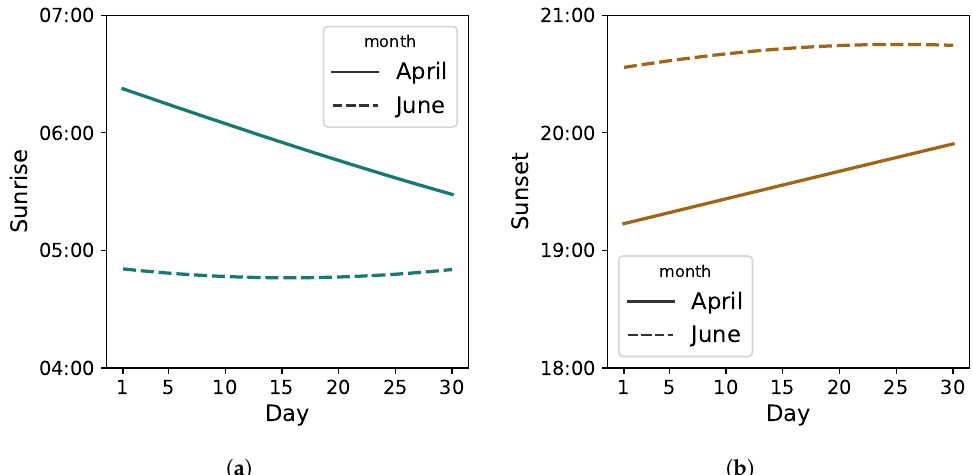
Figure 11. Sunrise ( a ) and sunset ( b ) times of June 2016 and April 2017 projected to the same figure to highlight the differences between the seasons, using data from